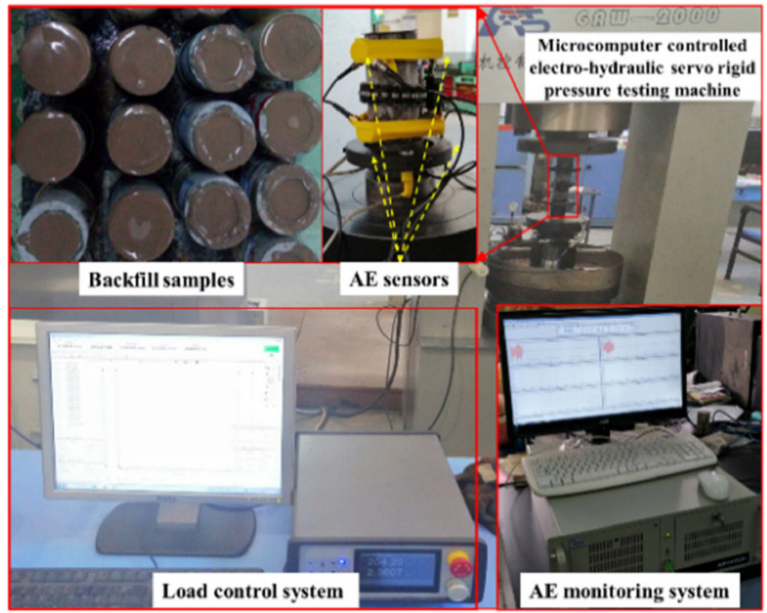
Figure 4. Uniaxial compressive AE test